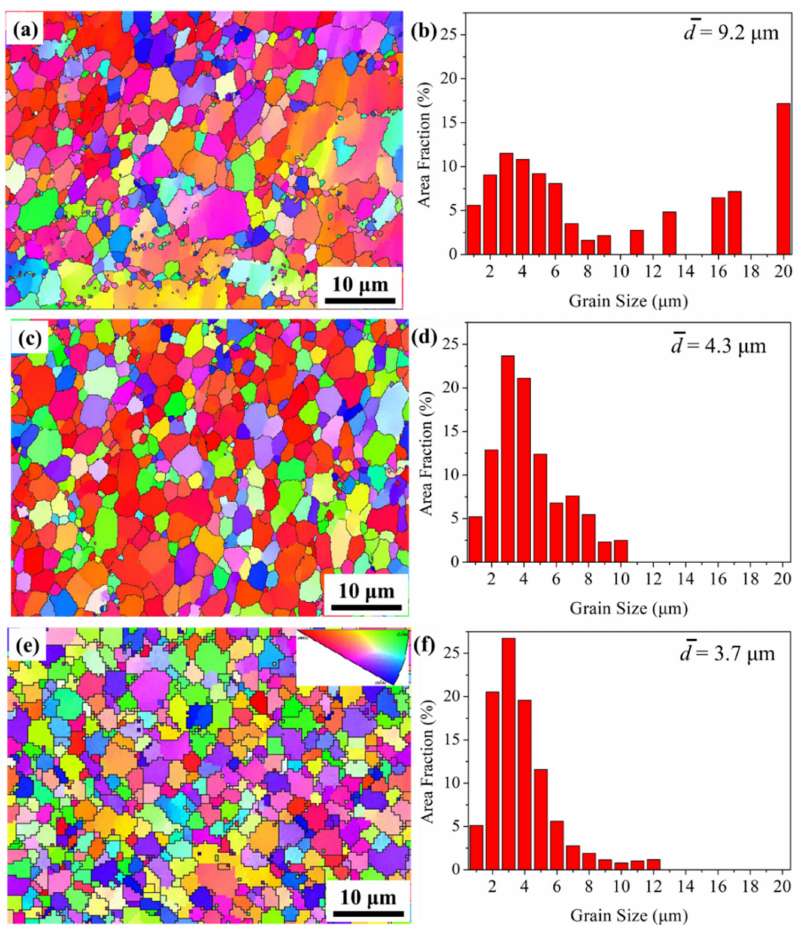
Figure 5. Electron back-scatted di ff raction (EBSD) maps and its corresponding grains distributions of